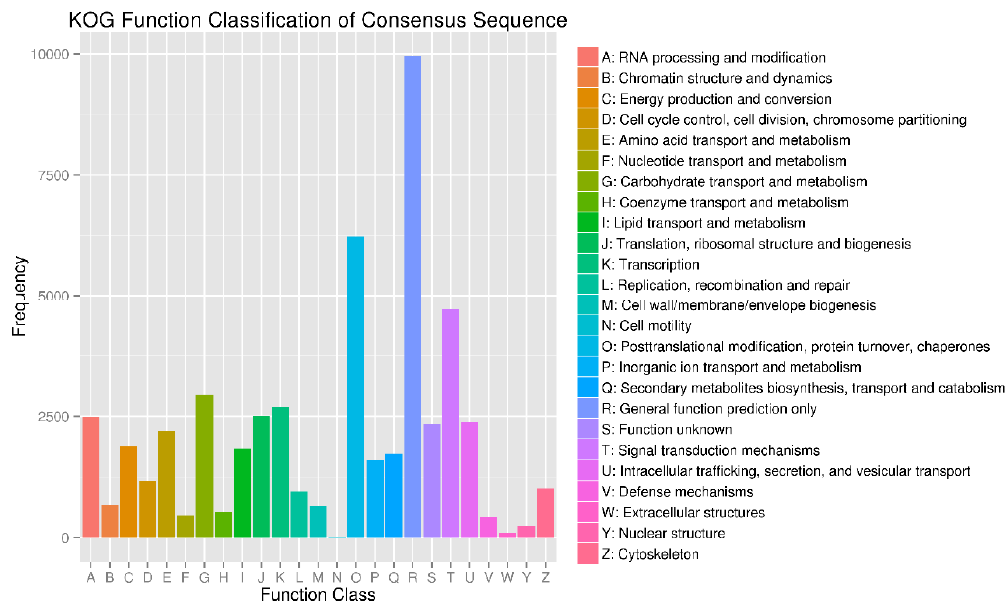
Figure A7. KOG function classification of the annotated high-quality transcripts obtained by TGS. The horizontal axis represents the KOG categories and horizontal axis represents the gene number.